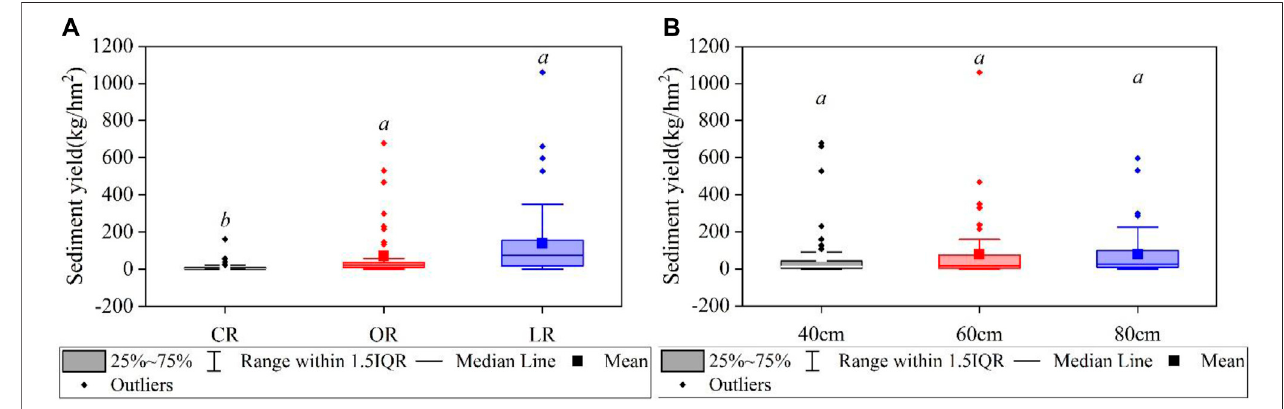
FIGURE 7 | Sediment yield under different ridge directions (A) and ridge widths (B) , and boxes labeled with different letters indicate signi fi cant differences at p < 0.05. CR, OR, and LR represent cross-ridge tillage, oblique-ridge tillage, and longitudinal-ridge tillage, respectively. 40, 60, and 80 cm represent 40 cm ridge width, 60 cm ridge width, and 80 cm ridge width, respectively.